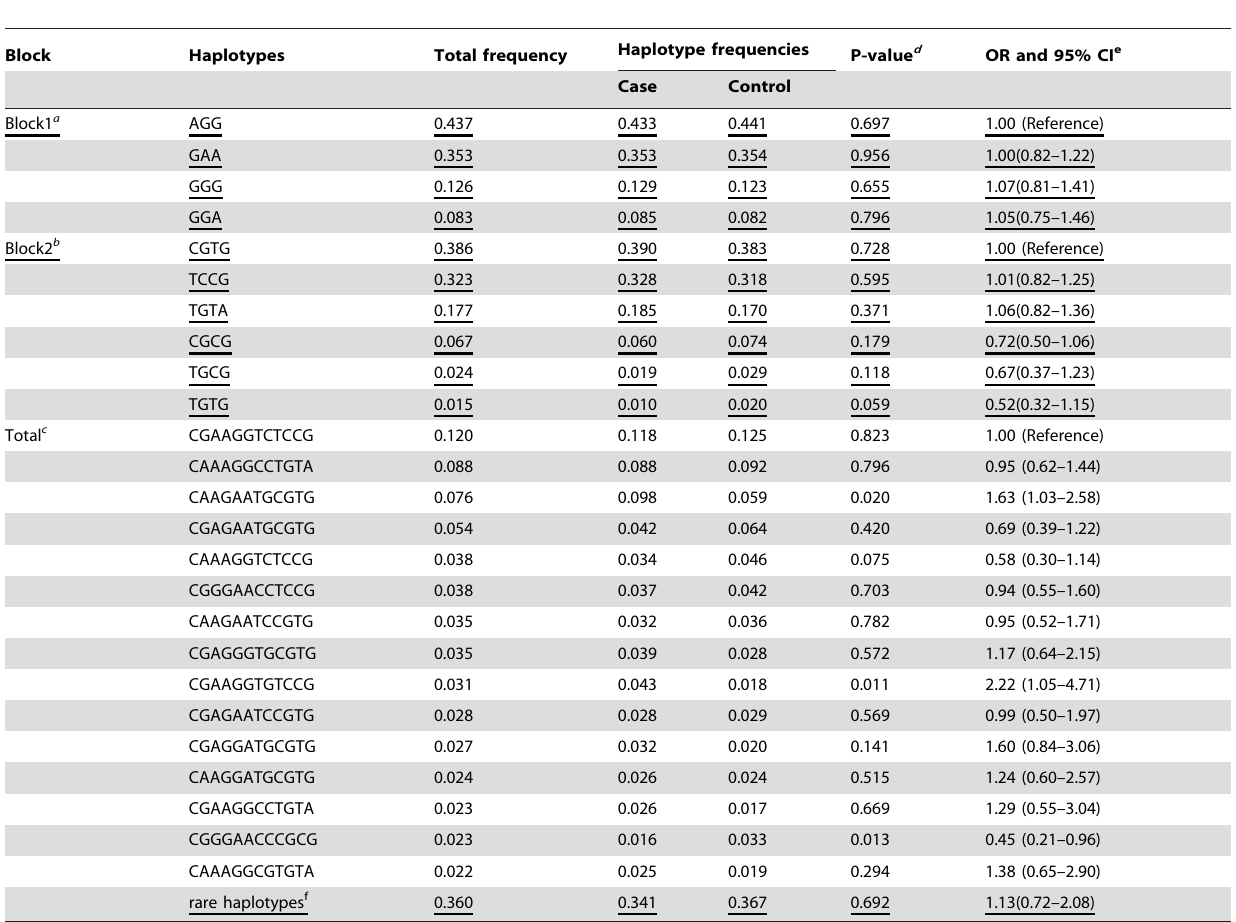
Table 3. Associations between risk of NAFLD and frequencies of inferred haplotypes on the basis of the observed genotypes in NAFLD cases and